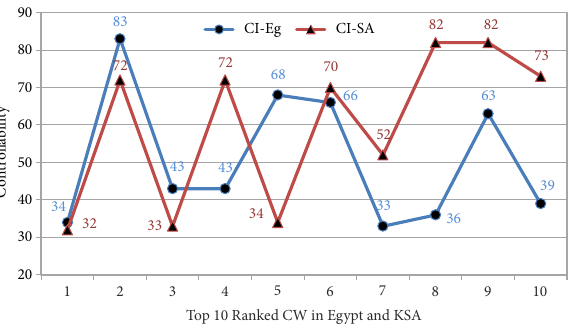
Figure 6. CI for top 10 ranked CWs